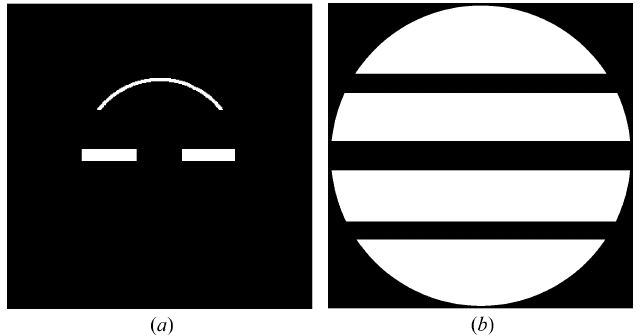
Figure 3 ( a ) The mask used to detect hits and ( b ) the background mask. Note that, as a result of the non-zero tilt of the liquid injector nozzle, the near- meridional peaks generally appear only in the upper half of a diffraction